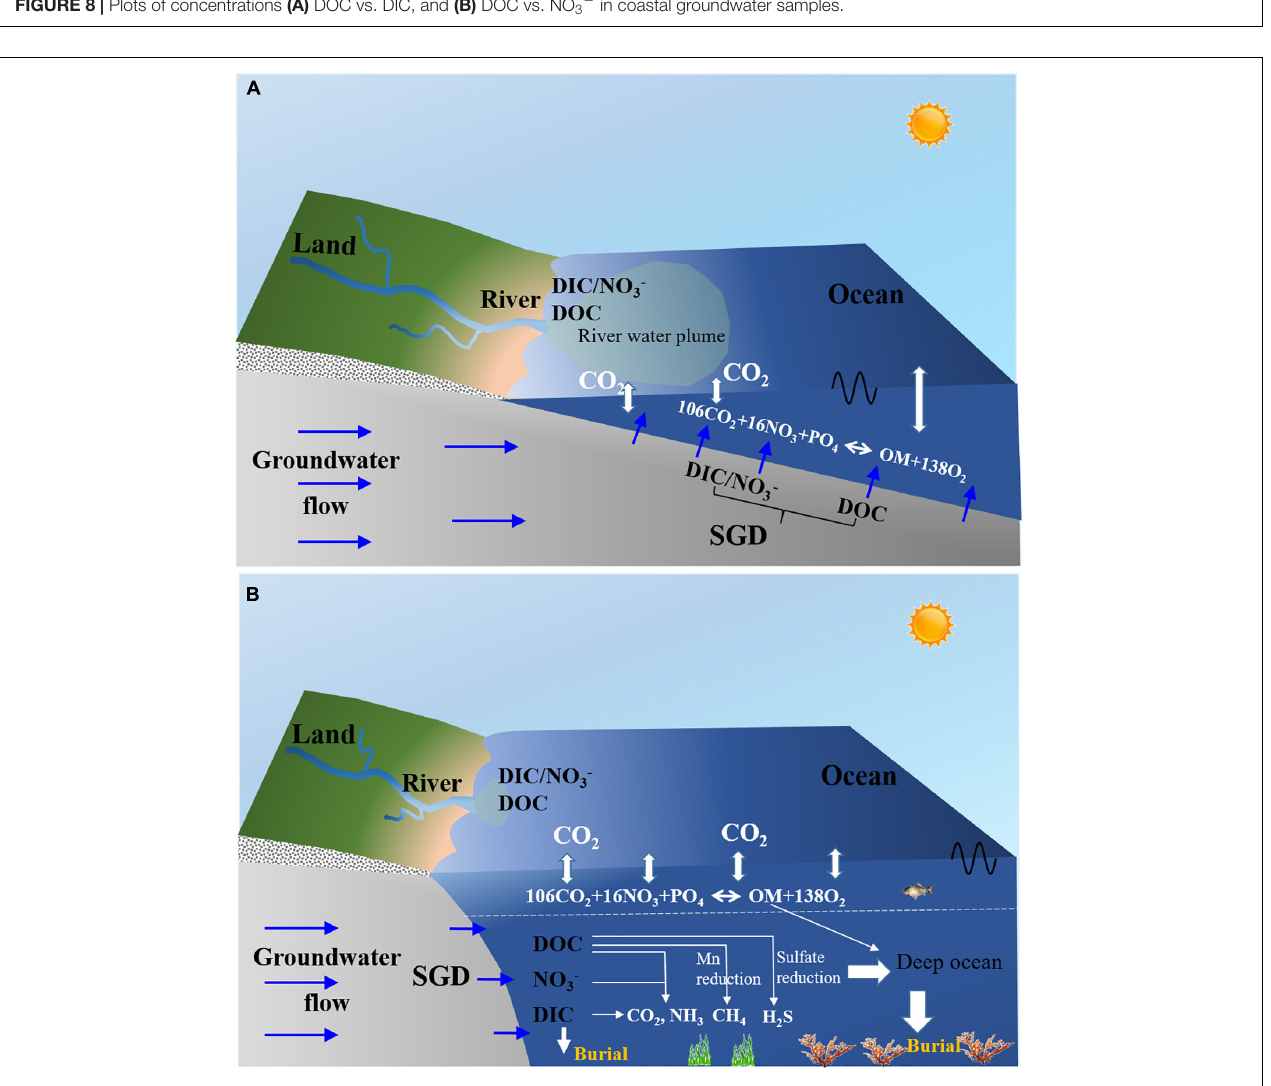
bottom of the ocean which will potentially result in hypoxia and acidification at the bottom water body. Combined with the processes of nitrate and DOC, SGD is a potential net